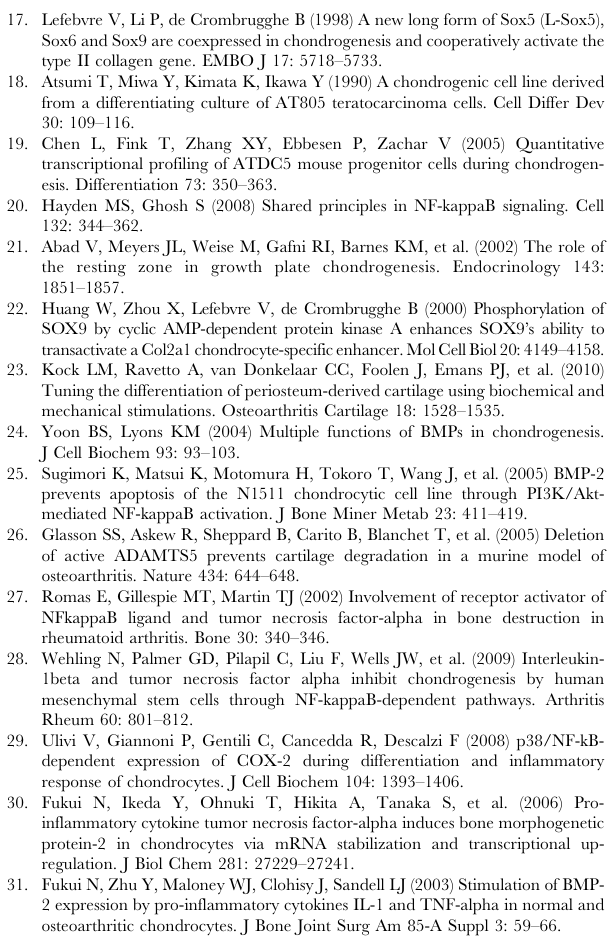
Figure S5 Connection between early NF- k B/p65 activa- tion and growth factor expression in ATDC5 chondro- genic differentiation. Table S1 DNA oligo sequences for